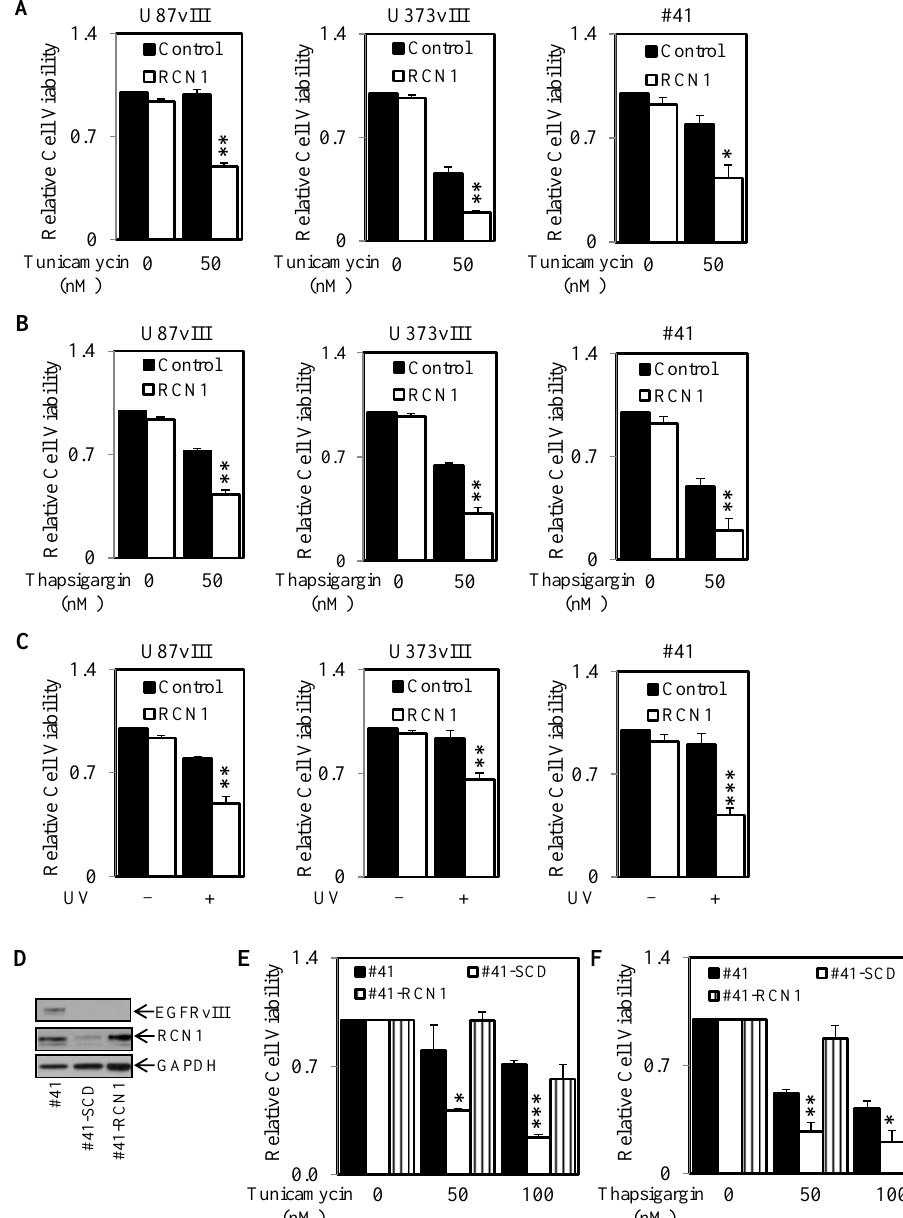
Figure 4. RCN1 knockdown reduces and RCN1 over-expression increases cell survival after exposure to tunicamycin, thapsigargin and UV light. U87vIII, U373vIII and #41 glioblastoma cells were transfected with control ( (cid:4) ) or RCN1 ( (cid:3) ) siRNA and then treated with ( A ) ± tunicamycin (50 nM), ( B ) ± thapsigargin (50 nM), or ( C ) ± exposure to UV light. Cell viability was then determined after 72 h using a commercially available Cell Titer-Glo kit and samples read on a bioluminometer as described in Figure 3. Data are expressed as % viability compared to untreated cells ± S.D of at least 3 independent experiments, each with 3 experimental replicates. ( D ) #41, #41-SCD and #41-RCN1 cells were lysed and assessed for EGFRvIII, RCN1 and GAPDH expression by Western blot. #41 ( (cid:4) ), #41-SCD ( (cid:3) ) and #41-RCN1 (bars with vertical lines) cells were treated with ( E ) ± tunicamycin (50 nM) or ( F ) ± thapsigargin (50 nM) and cell viability was then determined after 72 h as described above. * p < 0.05; ** p < 0.01; *** p < 0.001.